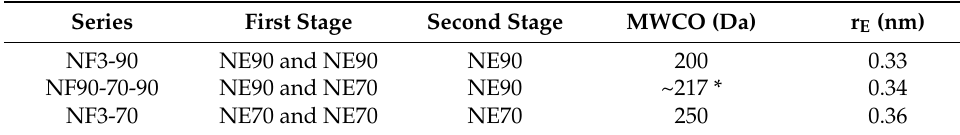
Table 3. Investigated nanofiltration element